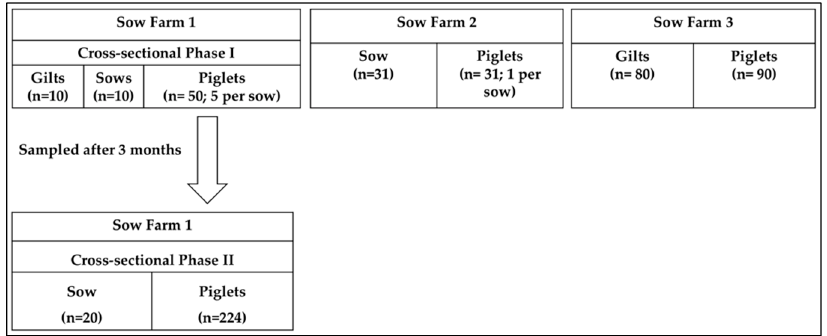
Figure 1. Cross-sectional study designs by farm with the number of fecal samples by pig category.